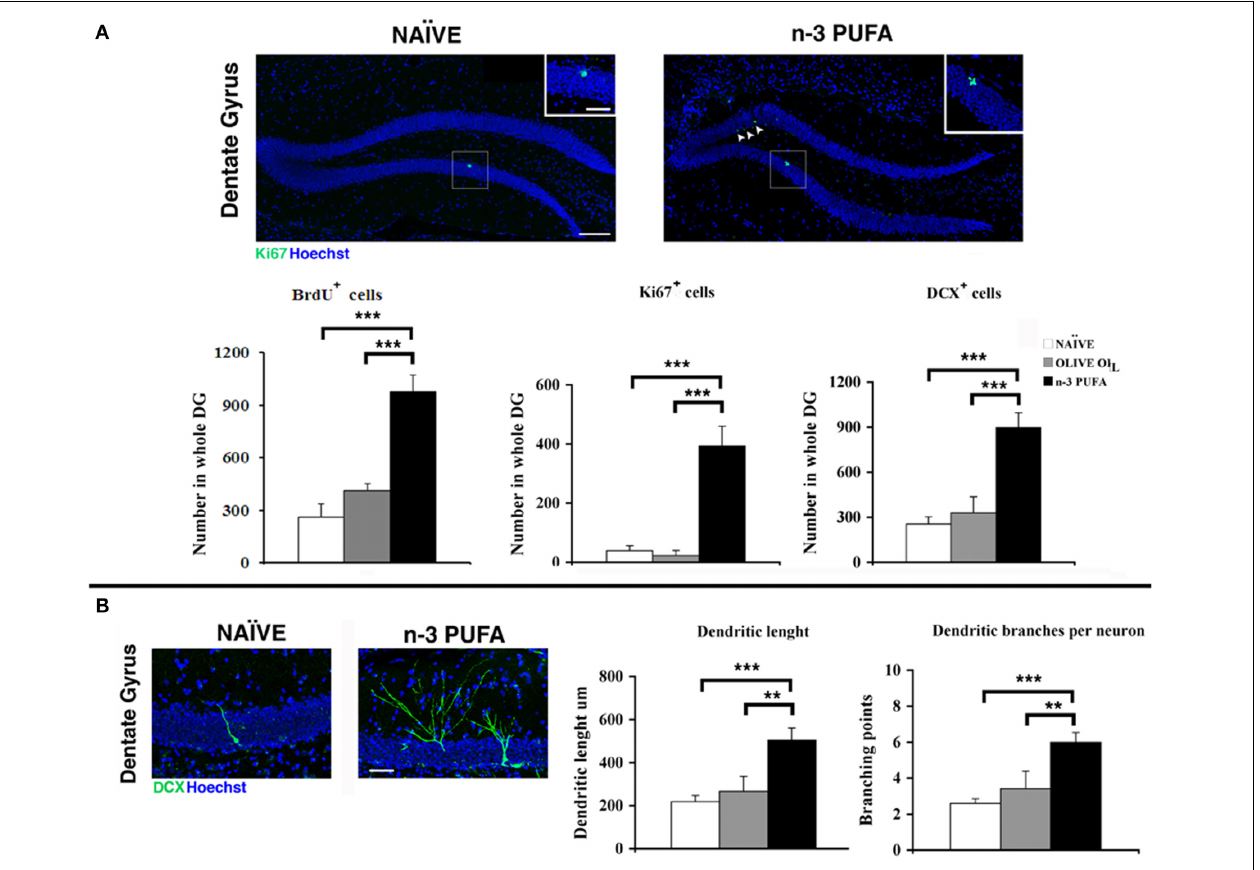
FIGURE 5 | n-3 PUFA effects on hippocampal neurogenesis. (A) Representative images showing the increase of the Ki67 + cells in the dentate gyrus of the mice treated with n-3 PUFA, when compared with NAÏVE group. At higher magnification (square boxes) the presence of a cluster of Ki67 + cells, which is a sign of intense proliferative activity can be noted for the n-3 PUFA treated mice (right panel), but not for the NAÏVE mice (left panel). Scale bars 50 μ m and 25 μ m. The histograms show the increase